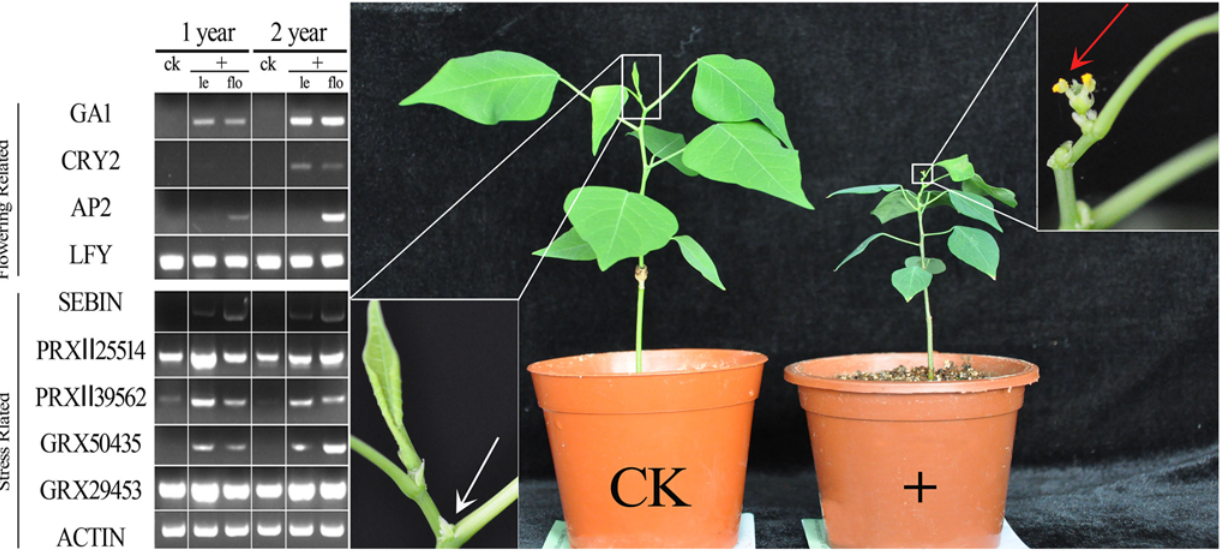
Fig 7. Drought induced flowering (right) and analysis of the expression of related genes by semi-quantitative PCR (left). Under drought stress, one- year-old seedling (+ in right) began to bloom (red arrow indicating the staminate flowers of S. sebiferum ) and normal control (CK at the left) performed no flower or flower bud on the shoot apex (white arrow). Besides the difference of flower, the precocious-flowering seedling had distinct phonotype of senescence, such as dark leaf color and withered leaf tips. The expression of genes related with flowering and drought stress has been analyzed by semi- quantity PCR, and detailed discussion has been shown in text. le, leaves tissue; flo, flower